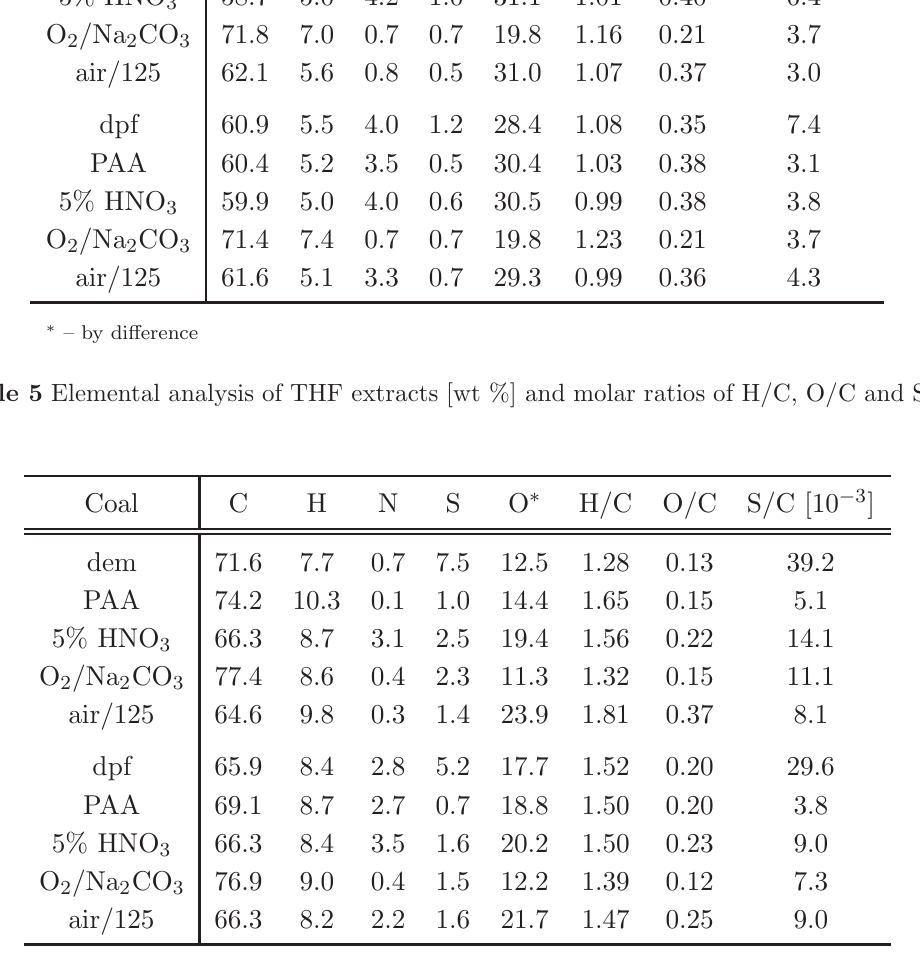
Table 6 Elemental analysis of CH 2 Cl 2 extracts [wt %] and molar ratios of H/C, O/C and S/C.